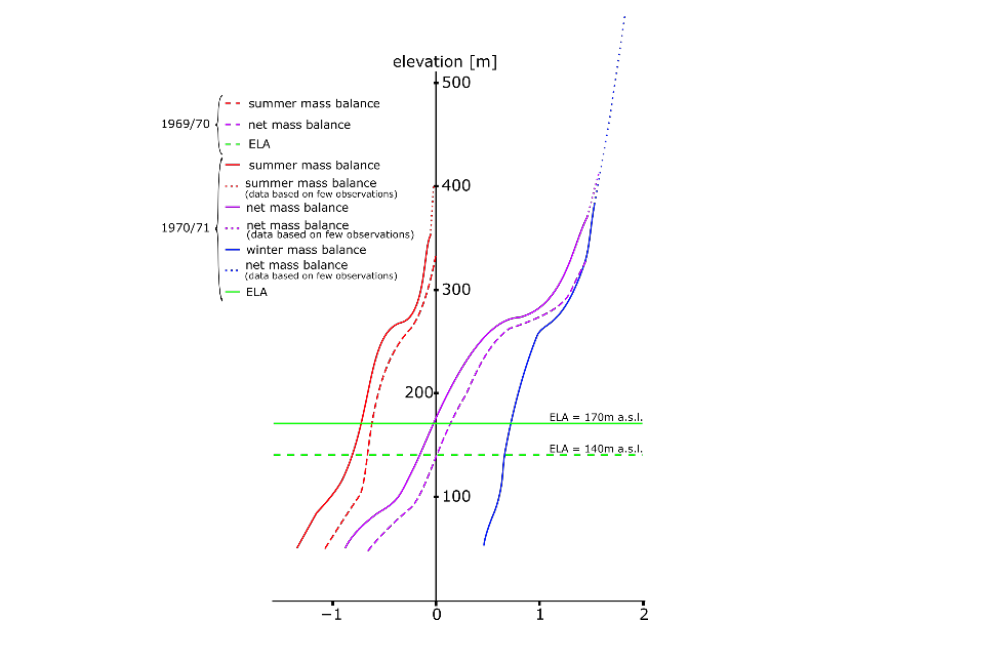
Figure 5. Net mass balances and ELAs on KGI, recorded from 1969 – 1971 mainly on the BD and AI. Reprinted with permission from Orheim and Govorukha [26], published by Cambridge University Press, 1982.